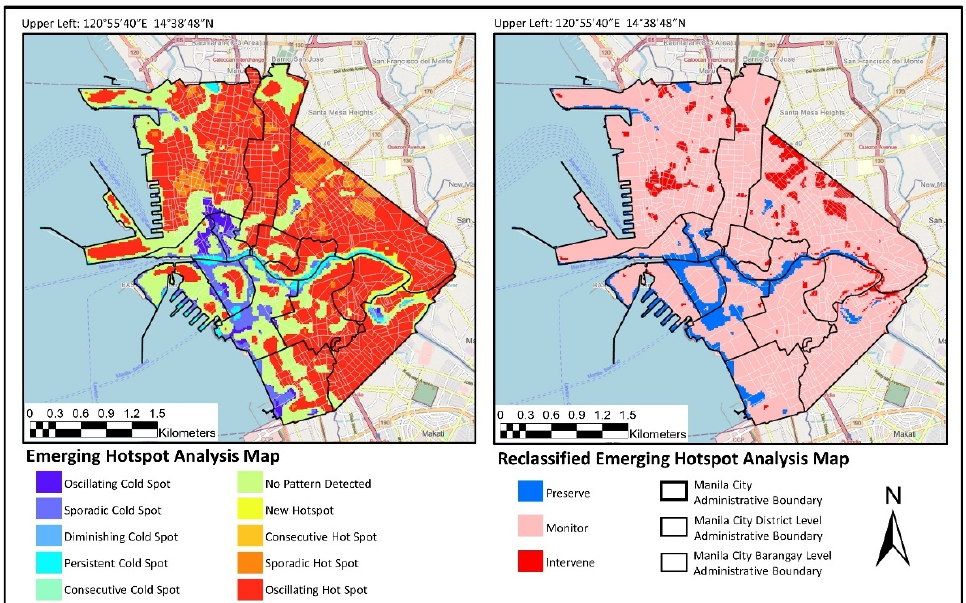
Figure 10. Emerging Hotspot Analysis Map and the reclassified map with the corresponding new class.